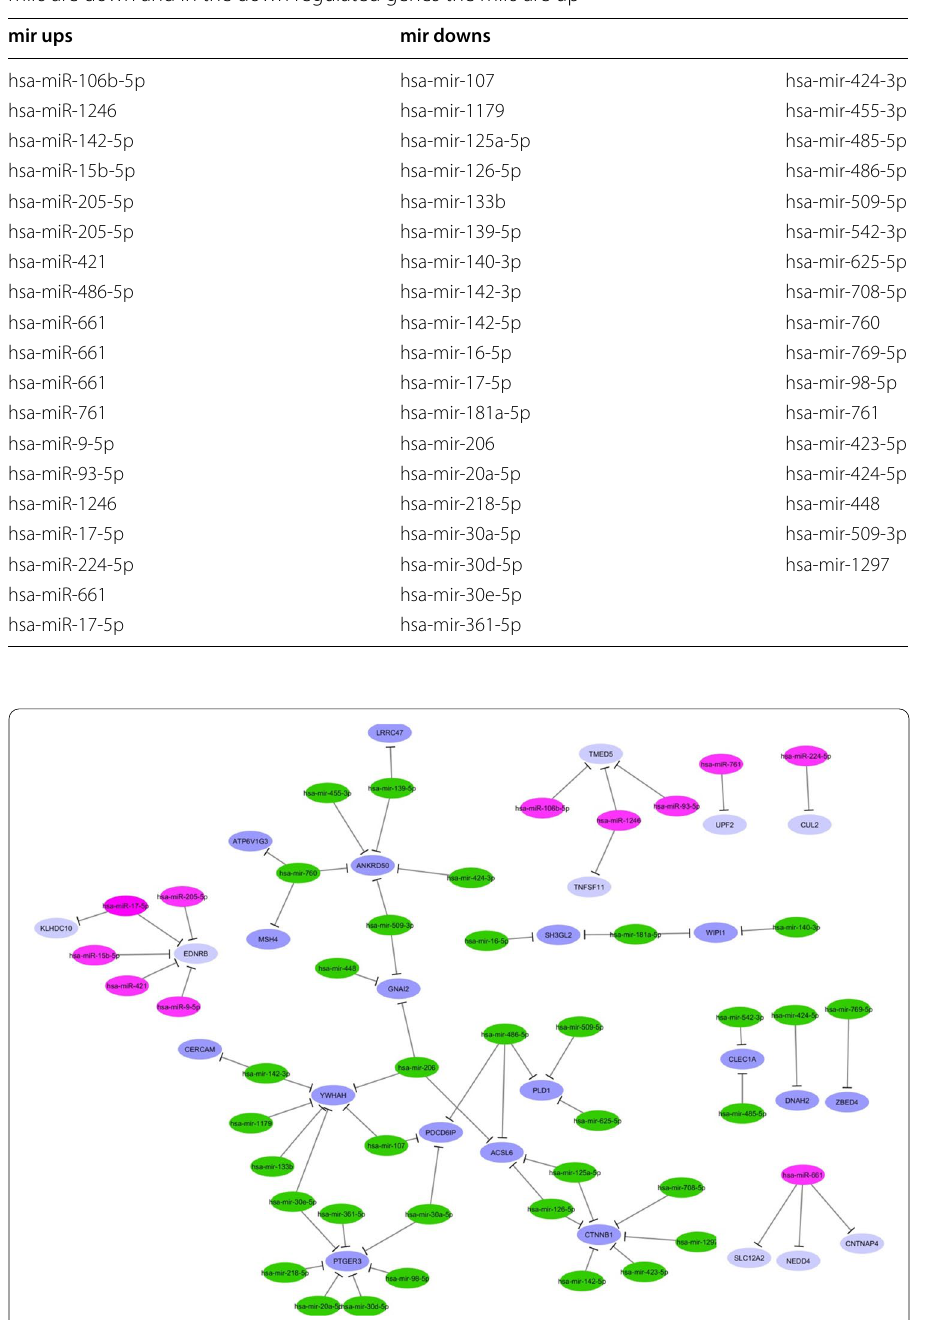
Fig. 4 Network of